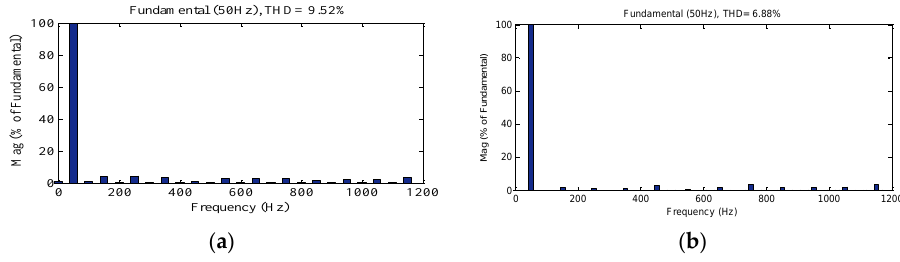
Figure 14. Output voltage FFT analysis of THD present in of 9-level CHB-MLI without filter using by ( a ) PV based boost converter obtained by P&O MPPT ( b ) PV based boost converter obtained by FLC MPPT technique.